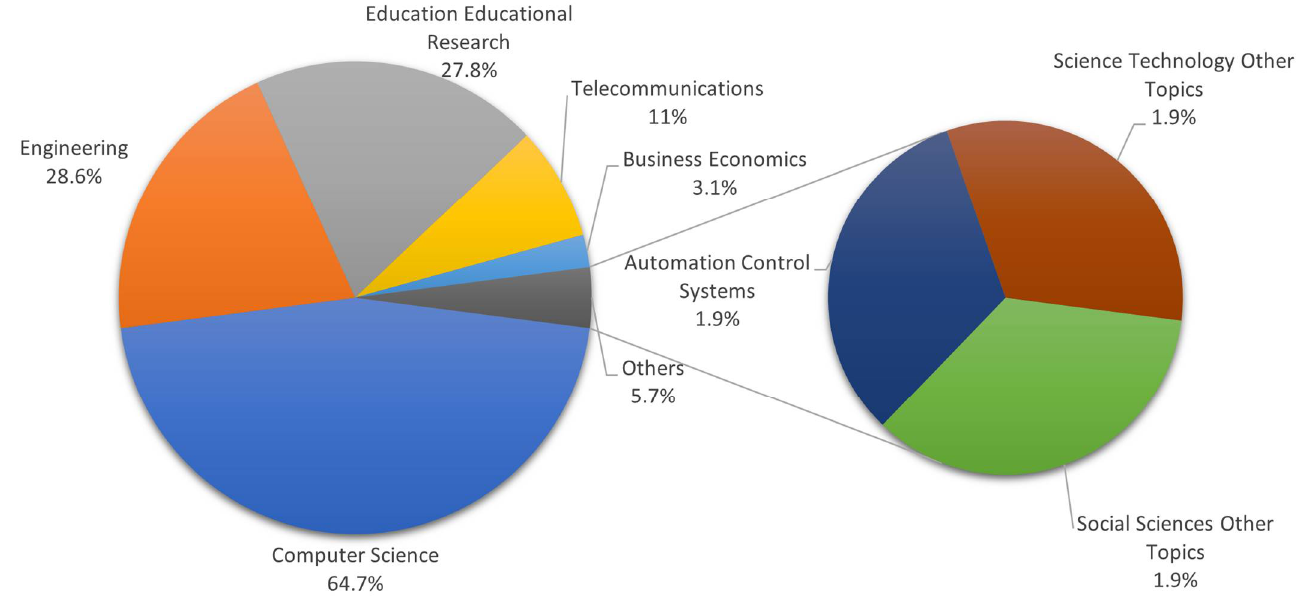
Figure 5. Most Published Categories in